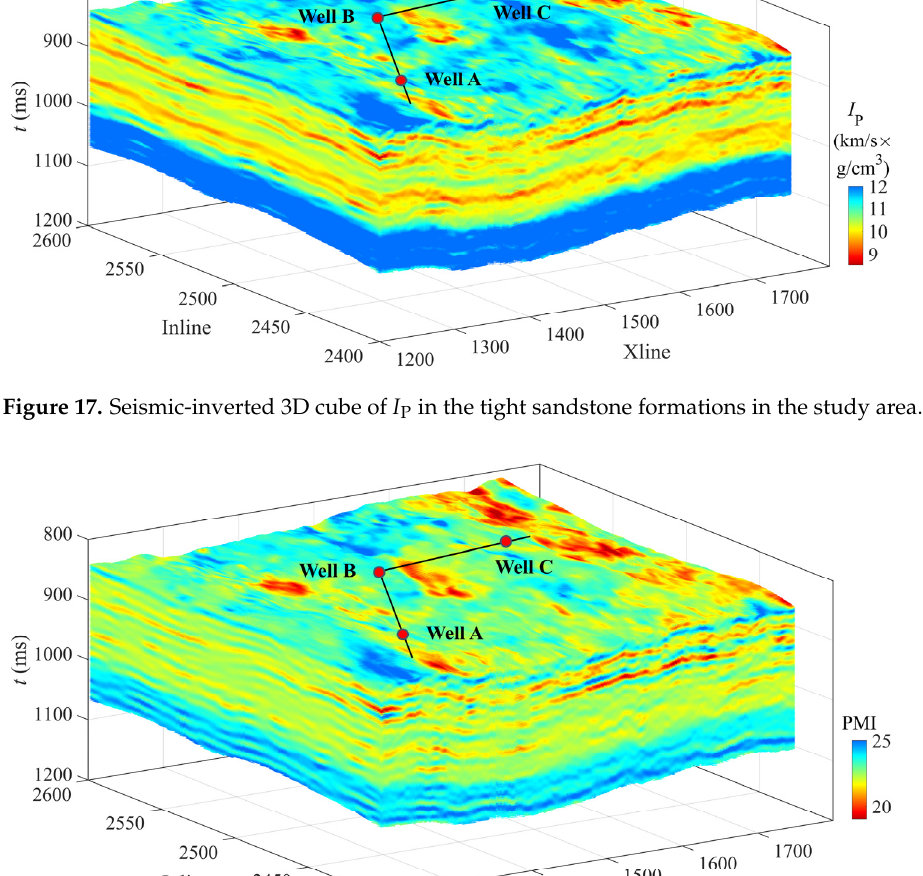
Figure 18. Computed 3D cube of the PMI in the tight sandstone formations in the study area.